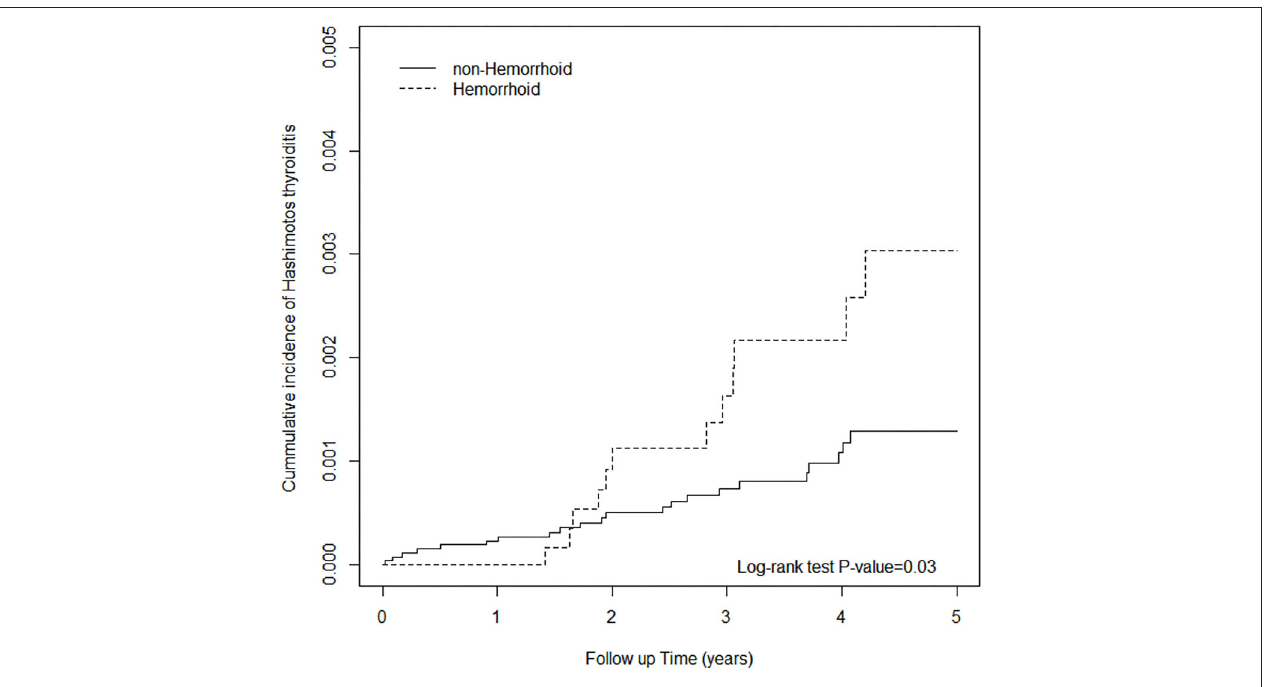
FIGURE 1 | Cumulative incidence of Hashimoto’s thyroiditis between individuals with and without hemorrhoids.